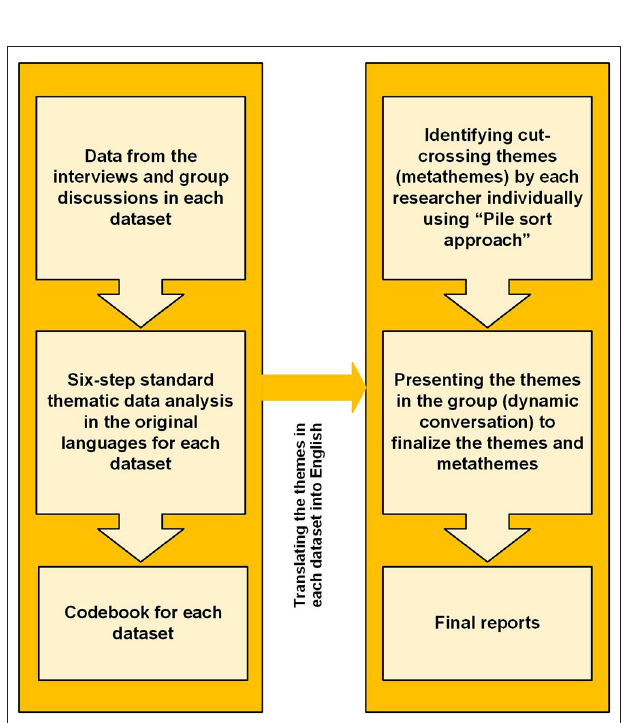
FIGURE 2 | Metatheme analysis process.